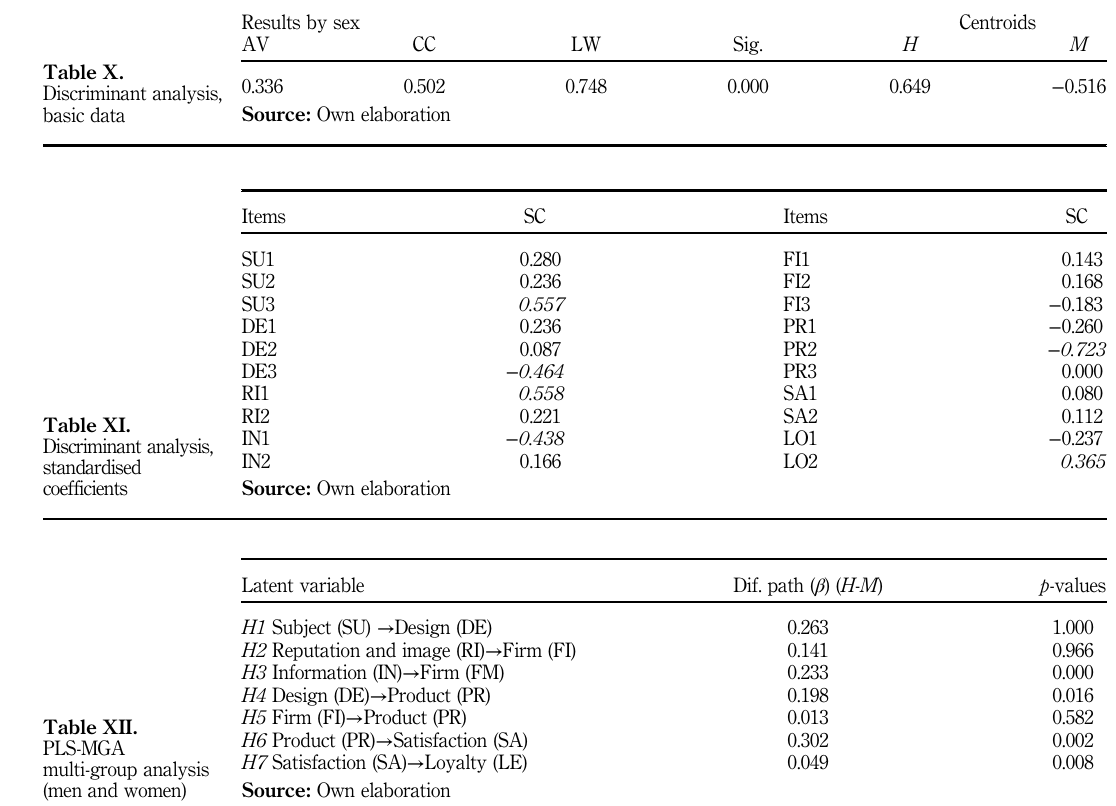
Table XII. PLS-MGA multi-group analysis (men and